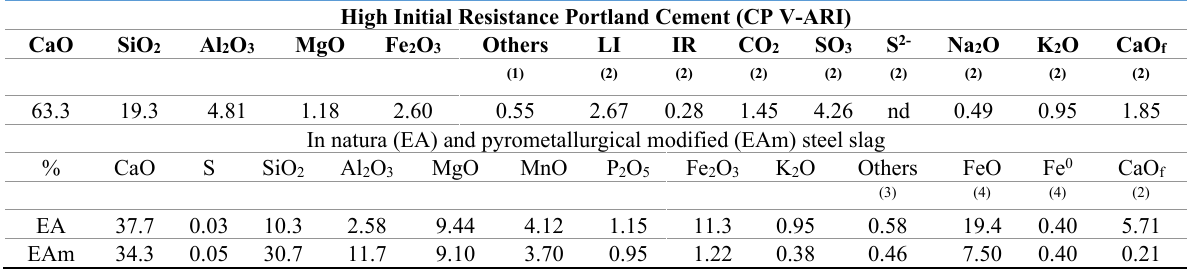
Table 3. Chemical characterization of Portland cement and steel slag